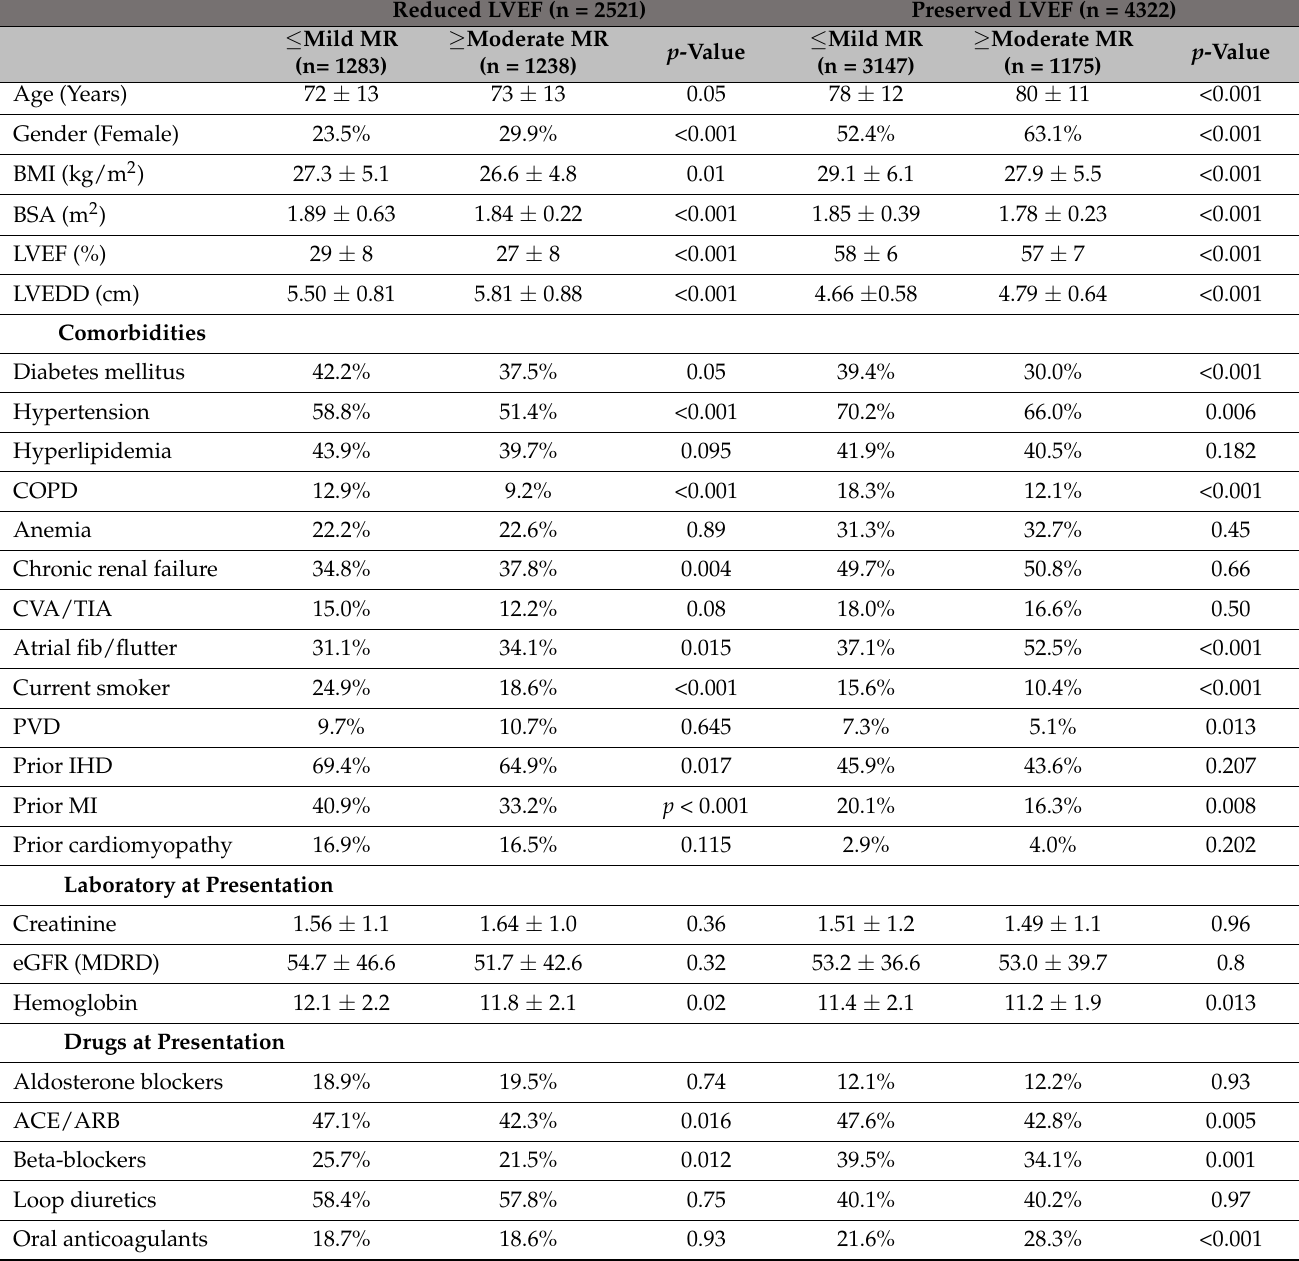
Table 2. Baseline clinical characteristics according to LV function and MR